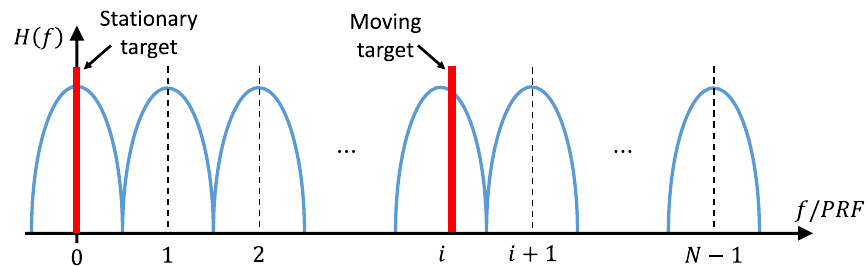
Fig. 2 Frequency response of a bank of filters (DFT) and the ideal spectrum of the useful signal (in